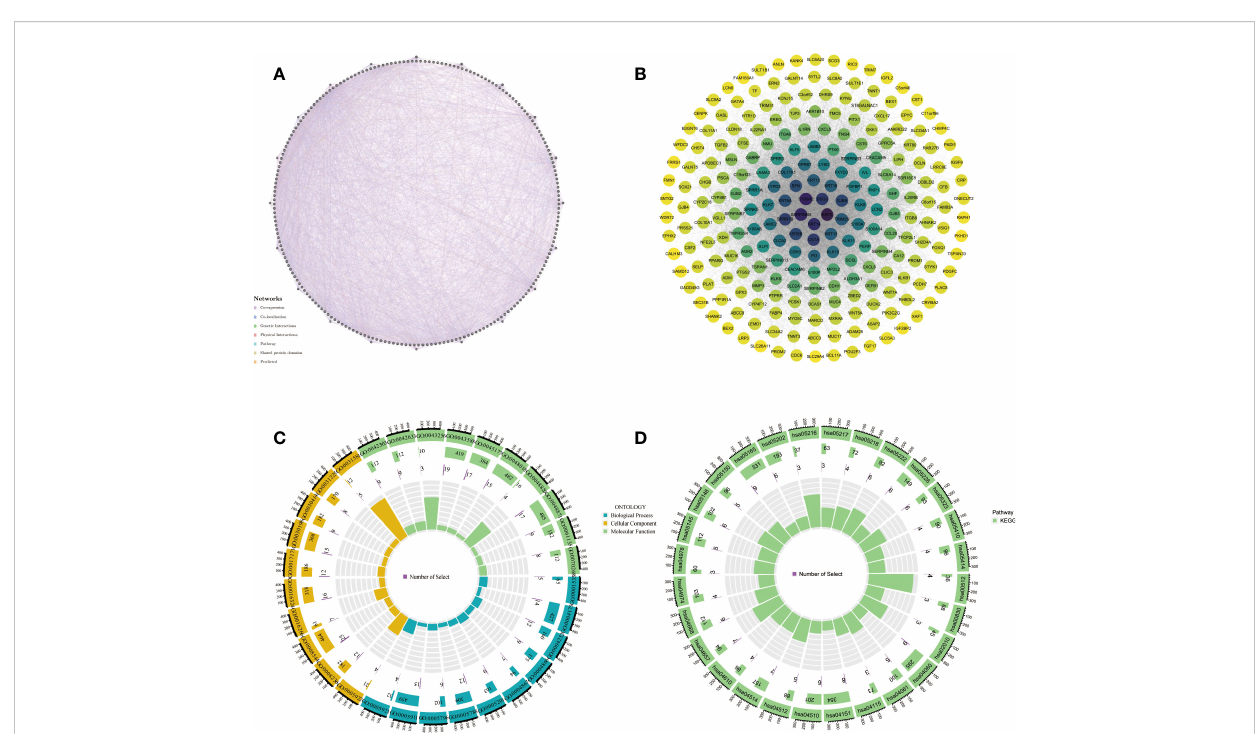
FIGURE 5 Bioinformatics analysis of genes obtained by WGCNA. (A, B) PPI network, (C, D) GO and KEGG enrichment